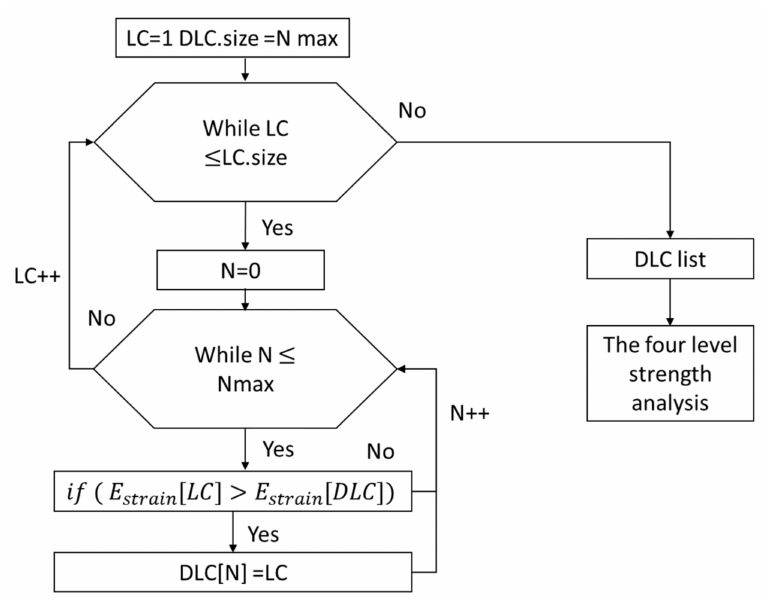
Figure 16. The scheme of searching of the wing-design load cases on the base of simple analytic beam model.